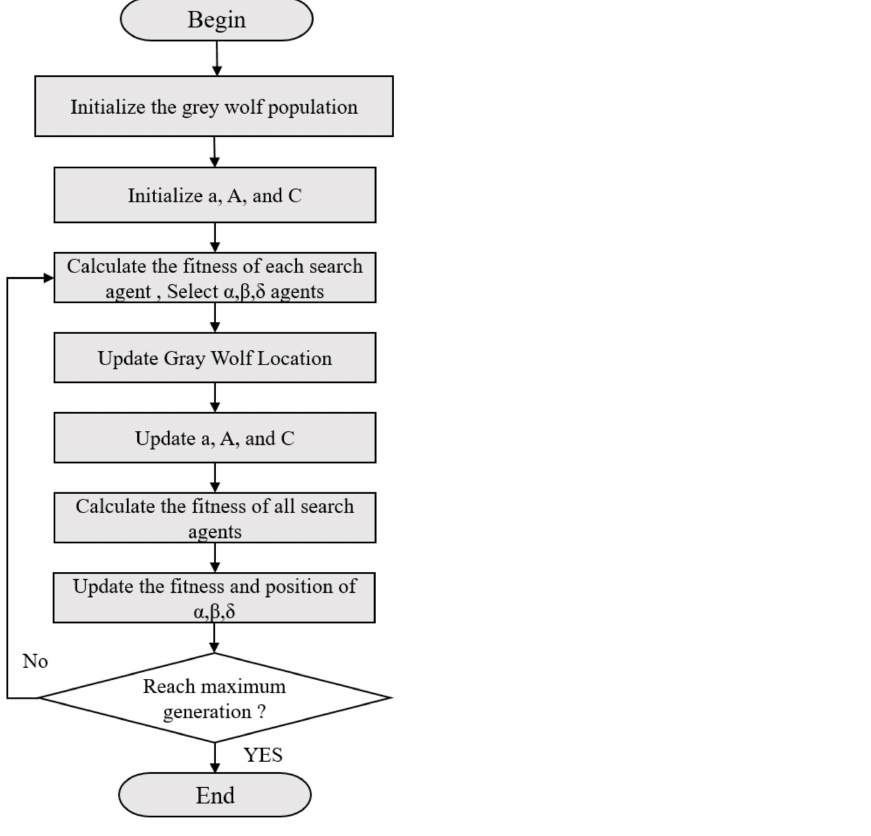
Figure 1. The flow chart of GWO algorithm. Where A is the convergence coefficient vector, C is the random coefficient vector, and a is the convergence factor.